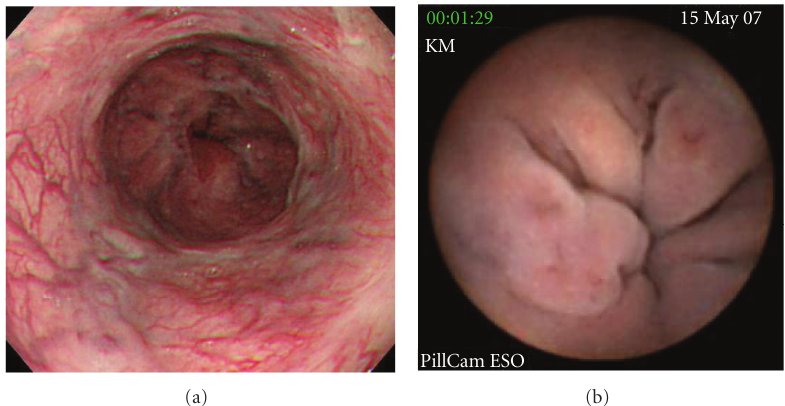
Figure 3: Images from a patient with poor agreement between EGD (a) and ECE (b). Varices were classified as F3RC1 by EGD (a), but as F2RC2 by ECE (b).